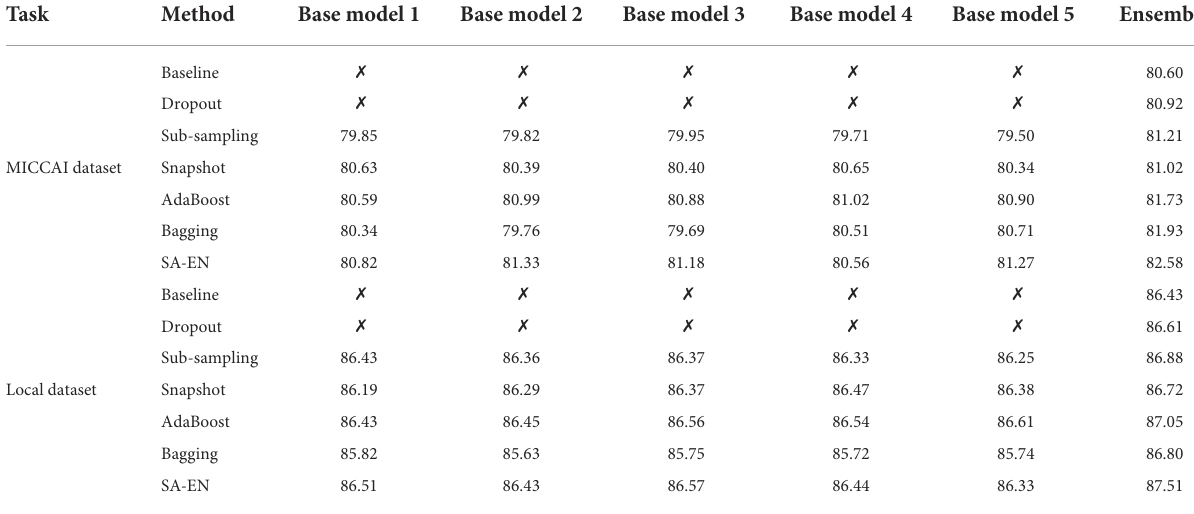
TABLE 2 Performance (Dice, %, higher is better) of different methods on two datasets.